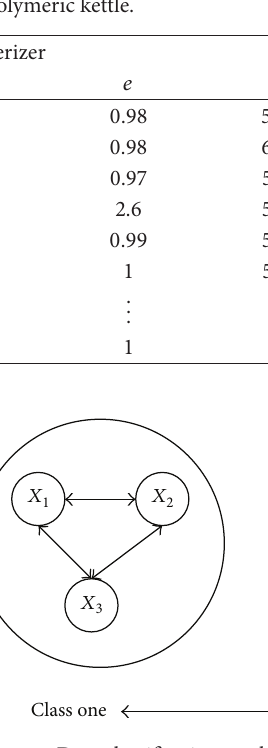
Figure 5: Data classification method based on Euclidean